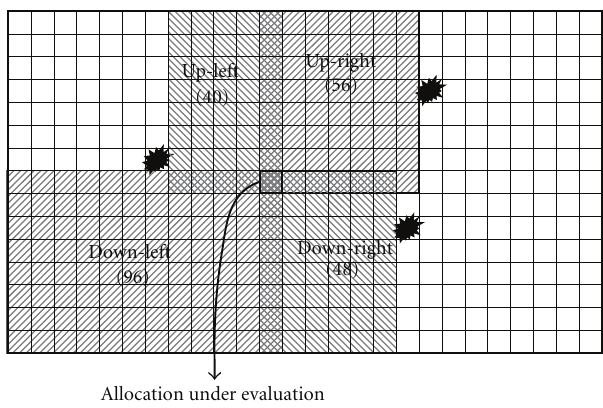
Figure 5: Greatest empty rectangles in up-right, up-left, down-right, and down-left